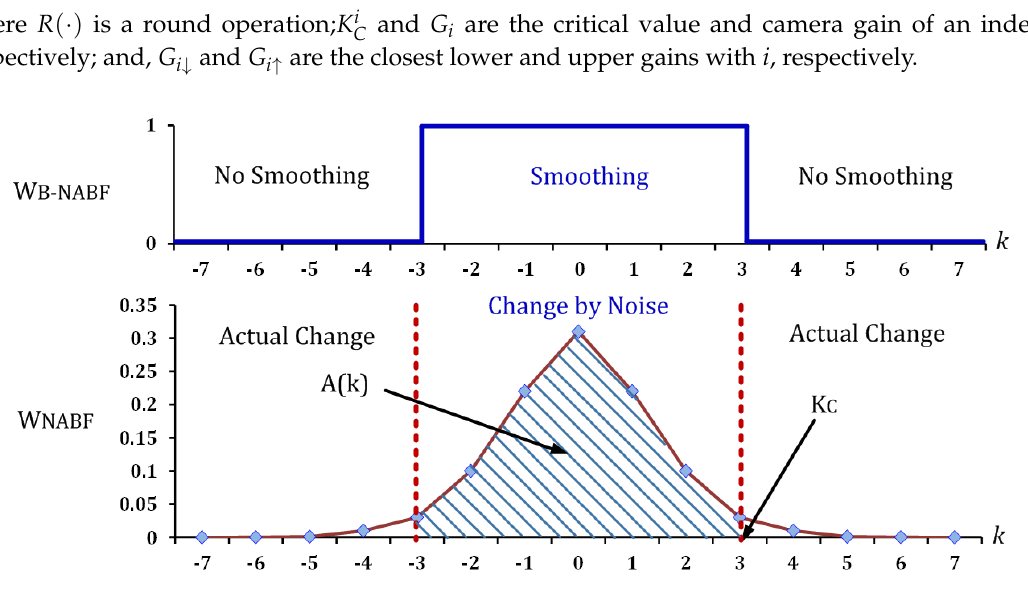
Figure 2. Binary noise-aware range kernel. Here, A [ k ] is the cumulative value of probability between two symmetric k s; K C denotes the critical value for a binary range kernel; and, W NABF and W B − NABF are weights by a noise-aware range kernel and a binary noise-aware range kernel,